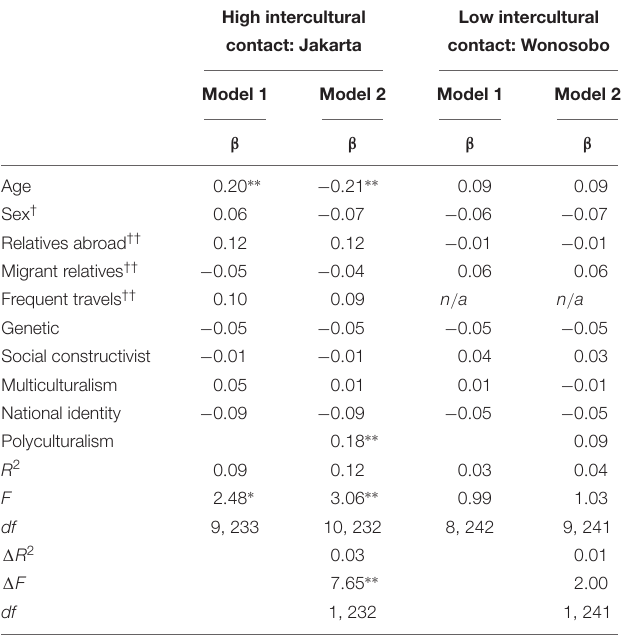
TABLE 6 | Summary of regression analysis predictors of attitudes toward continuing Dutch presence in two Indonesian